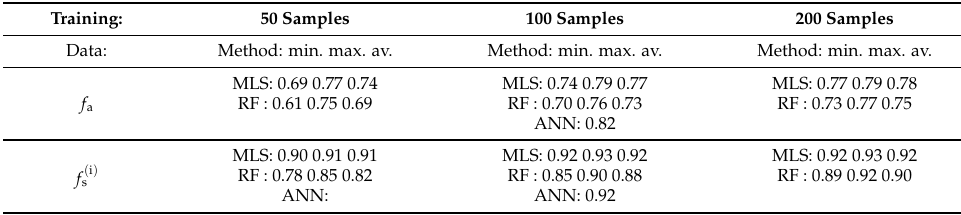
Table 3. The R 2 coefficient of determination, measuring the accuracy of the test sets, in the case of MLS, RF and ANN methods. For MLS and RF, 10 distinct partitions of the train-test sets were employed yielding the minimum, maximum and average R 2 . The ANN models confirm the performance attained by the previous two